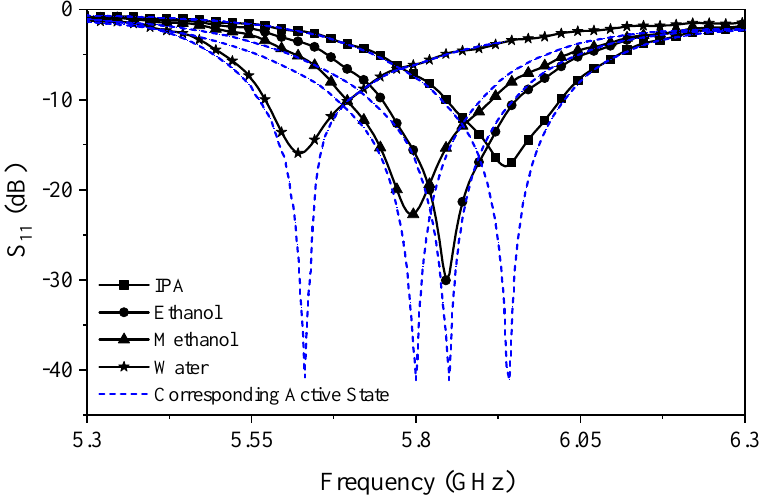
Figure 13. Common liquid measurement with/without loss